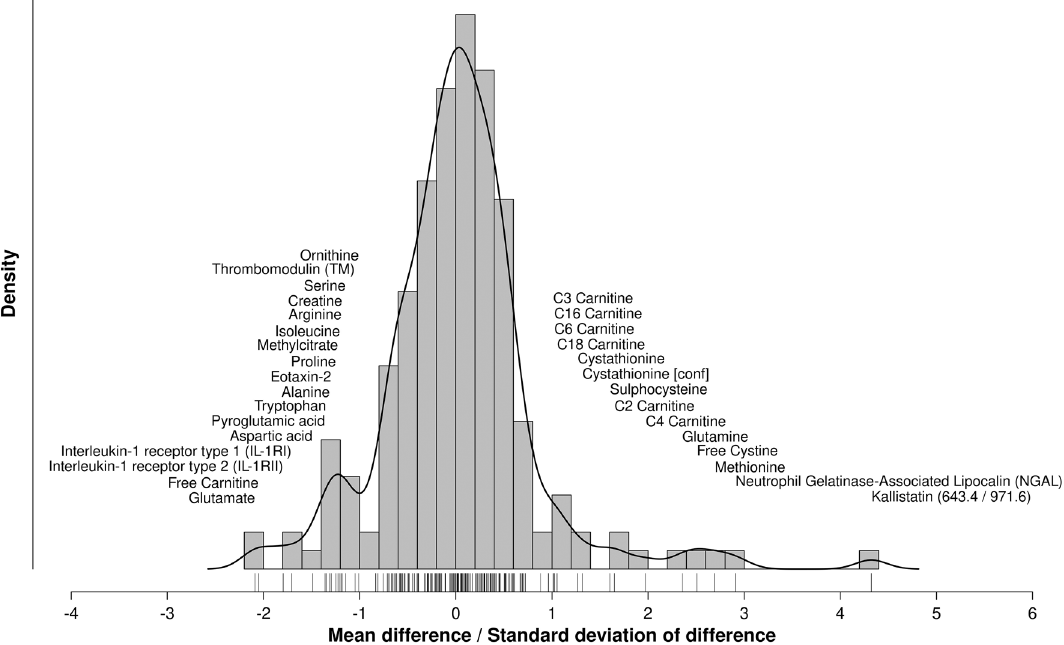
Figure 1. Distribution of mean difference between paired − 80 °C and − 20 °C samples divided by standard deviation of the difference for the analytes in the analysis. Tick marks on the x-axis show the individual data points and the solid line shows the nonparametric density estimator. Analyte names are shown for those with | S | > 1 d